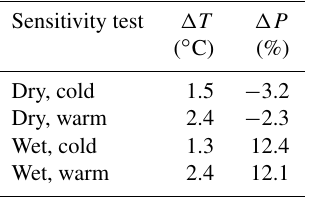
Table 3. Changes in temperature ( (cid:49)T ) and precipitation ( (cid:49)P ) for the climate sensitivity tests (same as Immerzeel et al., 2013).